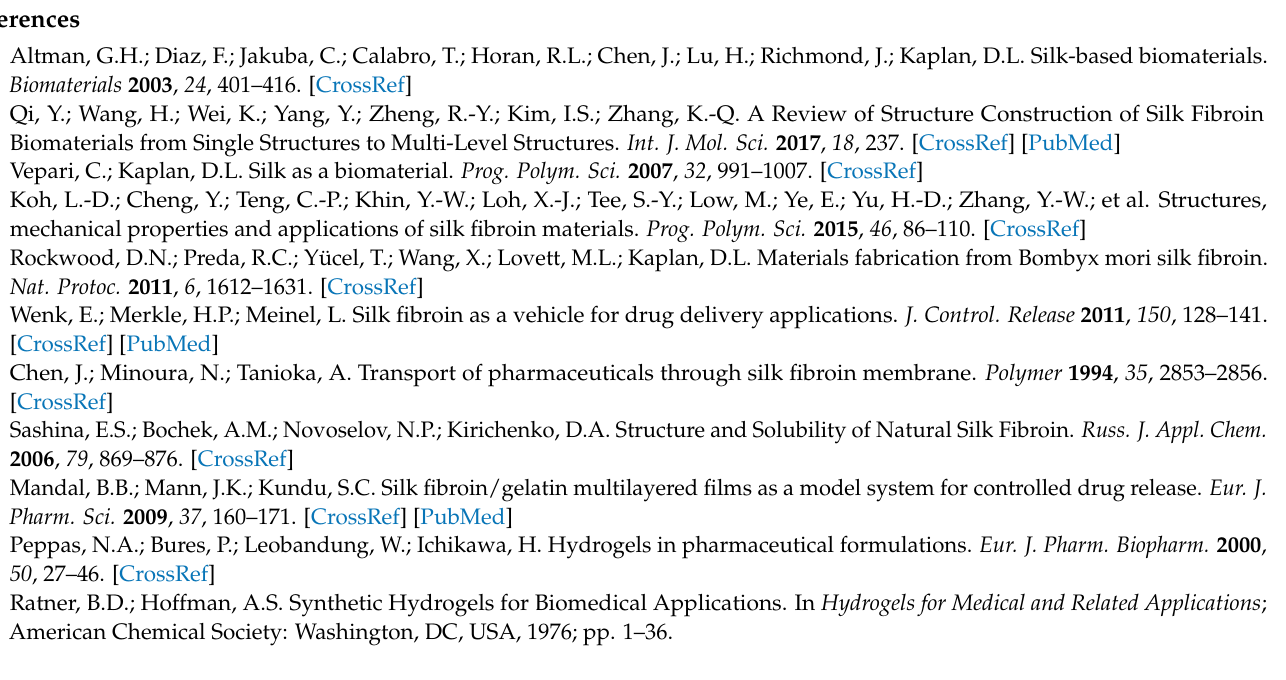
Figure S2: Optical microscopy image obtained from SF microparticles loaded with dyes, Figure S3: Confocal microscopy images of SF microparticles loaded with